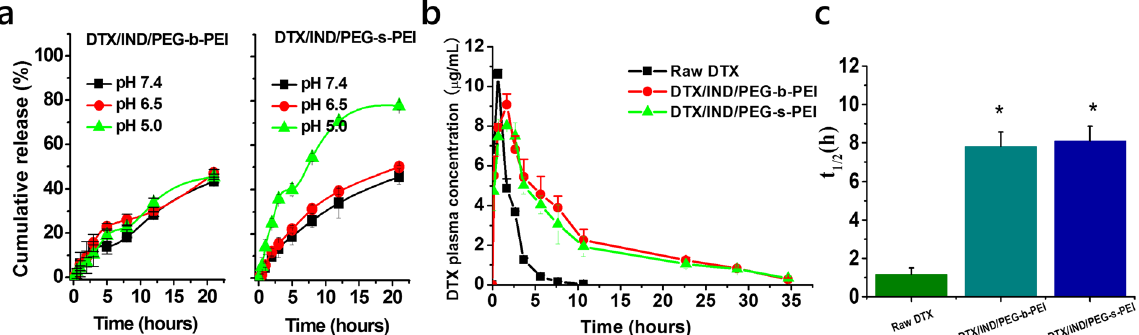
Figure 5. In vitro release and in vivo pharmacokinetic profiles of DTX/IND/PEG-s-PEI nanomedicines. ( a ) In vitro release profiles of DTX nanomedicines in the buffer simulating various pH conditions. Data are mean ± S.D. (n = 3). ( b , c ) Plasma concentrations ( b ) and t 1/2 of DTX of various DTX-loaded nanomedicines ( c ) after injected in SD rats at 10 mg/kg of DTX. Data are mean ± S.D. (n = 5). * p < 0.05 versus Raw DTX.